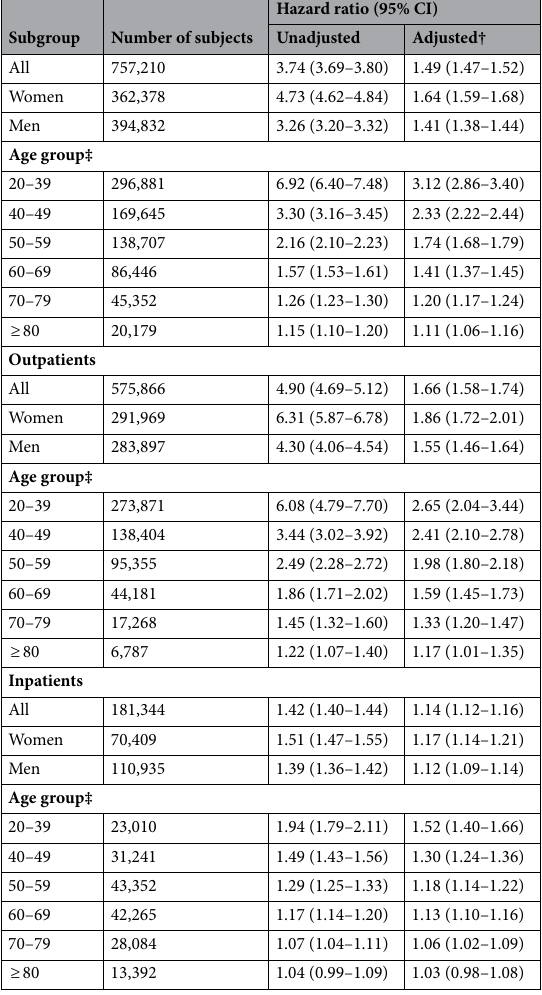
Table 2. Association of diabetes with mortality among subjects with COVID-19. * *Hazard ratios with 95% confidence intervals (CIs) were calculated using the Cox proportional-hazards regression. † Adjusted for age, sex, smoking habit, obesity, hypertension, cardiovascular disease, chronic obstructive pulmonary disease, asthma, chronic kidney disease, and immunodeficiency. A five-knot restricted cubic spline fitting was used for age. ‡ Hazard ratios were adjusted for age, sex, smoking habit, obesity, hypertension, cardiovascular disease, chronic obstructive pulmonary disease, asthma, chronic kidney disease, and